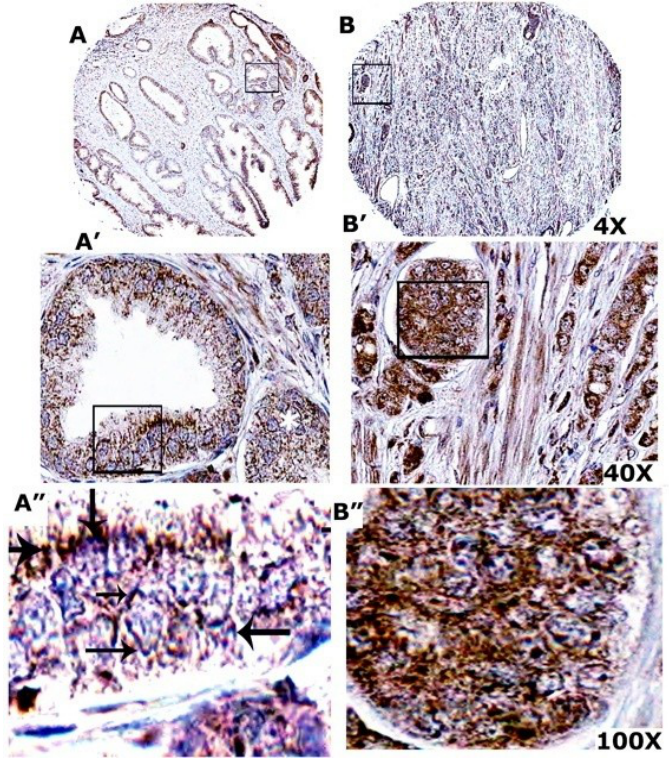
Figure 7. Immunohistochemistry on TMA derived from normal and cancerous prostate tissue. Immunohistochemical staining was performed with an antibody to VEGF in prostate cancer tissue array with adjacent normal prostate tissue. Normal tissue adjacent to prostate cancer is shown in ( A ). Prostate cancer filled lumen adjacent to normal prostate tissue is indicated by a white asterisk. Arrows in ( A'' ) point to membrane staining of VEGF in normal cells. Prostate carcinoma at grade 3 is shown in ( B ). Immunostained sections were counterstained with hematoxylin stain (blue). Location of the high magnification regions is indicated by a rectangle field in ( A ), ( A' ), ( B ), and ( B' ). Staining was repeated three times.